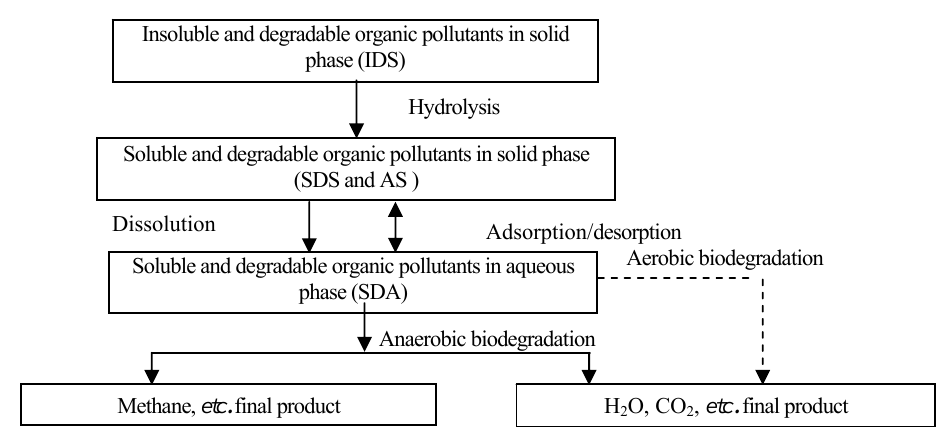
Figure 1. The biodegradation process of organics in